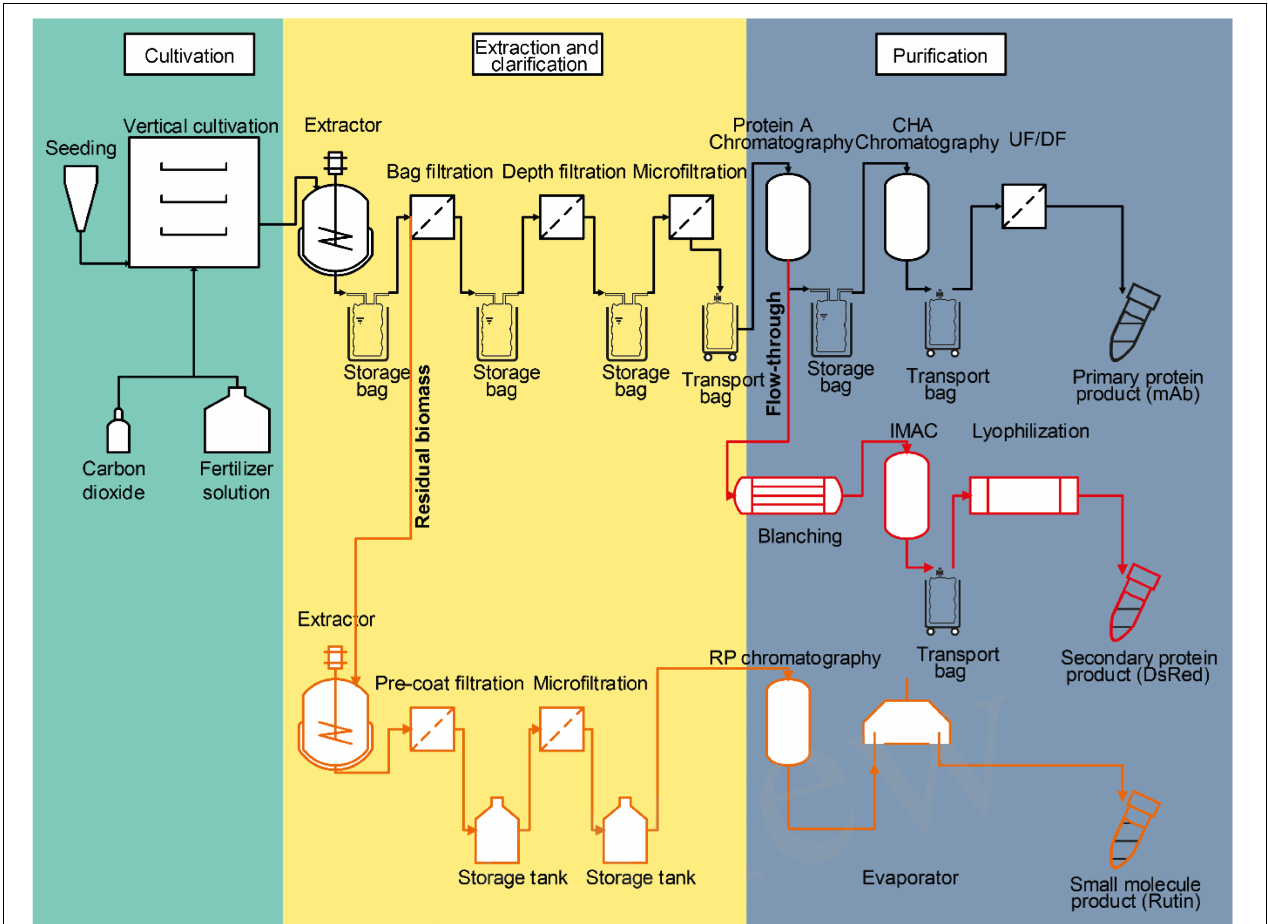
FIGURE 4 | Flow scheme of a partially integrated plant-based production process. The primary process (black) produces a high value pharmaceutical product, here, a mAb. Several side streams (bold) can be used to extract additional products. For example, a re-extraction of the residual biomass (orange) with an organic solvent can yield different small molecule products like rutin. Furthermore, co-expressed technical enzymes or diagnostic agents like DsRed can be isolated from liquid process wastes like the flow-through of a chromatography step (red). Each of the process branches stretch through one or several of the three typical process phases, i.e., plant cultivation (green background), extraction, and clarification (yellow background) and purification (blue background). CHA, ceramic hydroxyl apatite; IMAC, immobilized metal-ion affinity chromatography; RP, reversed phase; UF/DF, ultrafiltration/diafiltration.